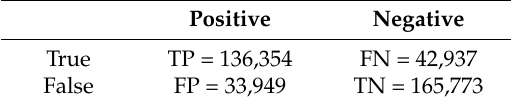
Table 9. Confusion matrix of the proposed BN.